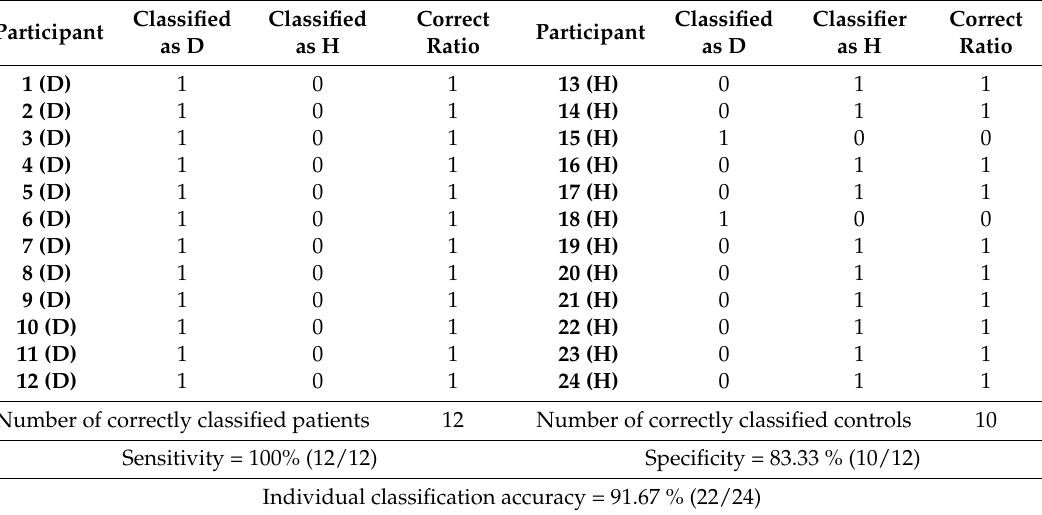
Table 7. The voting-based LOPO-CV results using the EEG signal of the first trial ( n t = 1), KEFB-CSP feature, and SVM classifier.